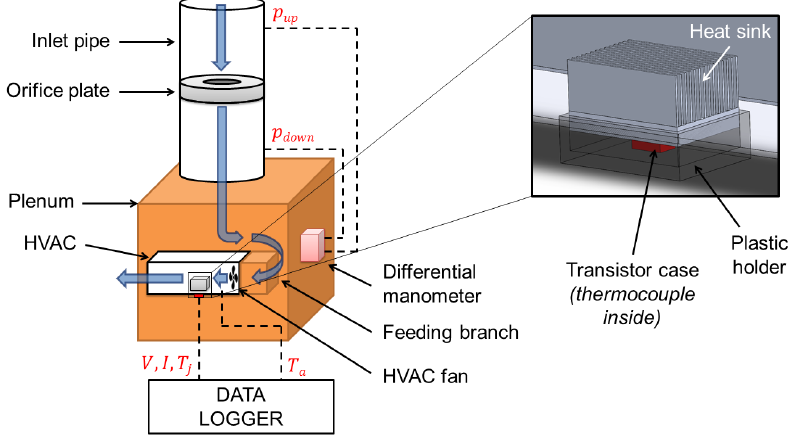
Figure 5. Scheme of experimental test rig used for heat sink